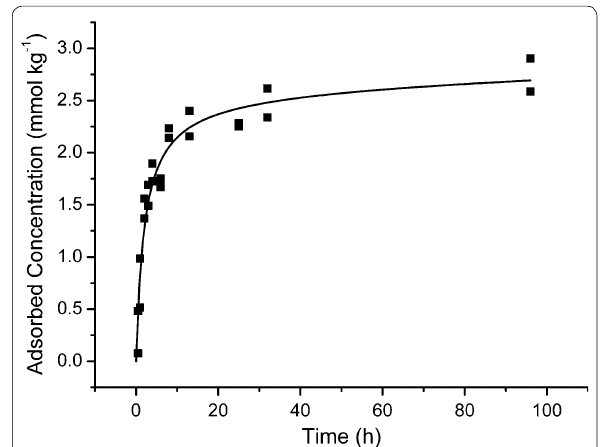
Fig. 1 Kinetics of d -gluconic acid adsorption onto gibbsite at pH 9 in 5 mmol L − 1 NaClO 4 solution. Data points: experimental values, solid line: two-stage kinetic model (TSKM), model fit: r 2 : 0.931, X 2 /DOF: 0.041